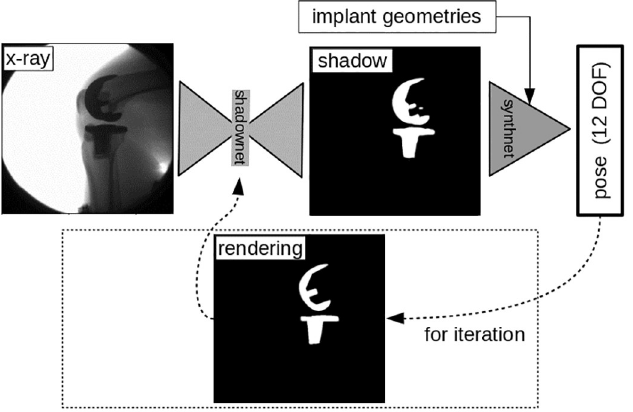
Fig 1. The shadownet extracts the implant shadow from the x-ray image, while the synthnet estimates the pose from this shadow for the known tibia/femur implant geometries.